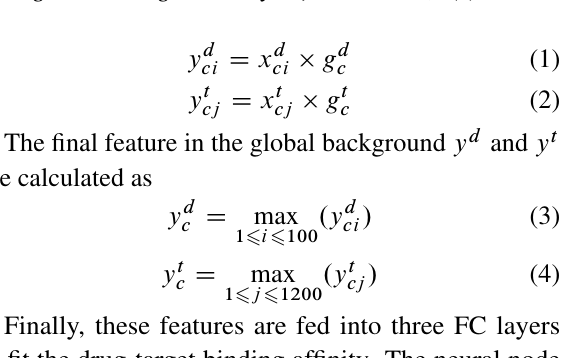
Table 1 Summary of Davis and KIBA data